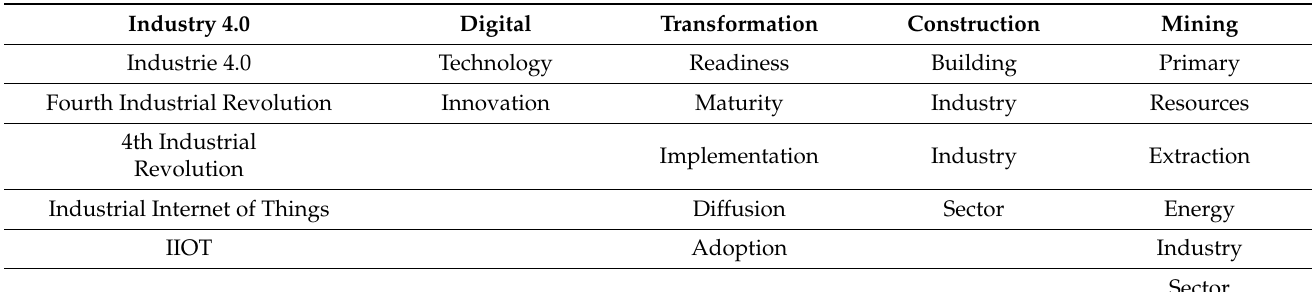
Table 1. Parameters used to query SCOPUS and Web of Science.